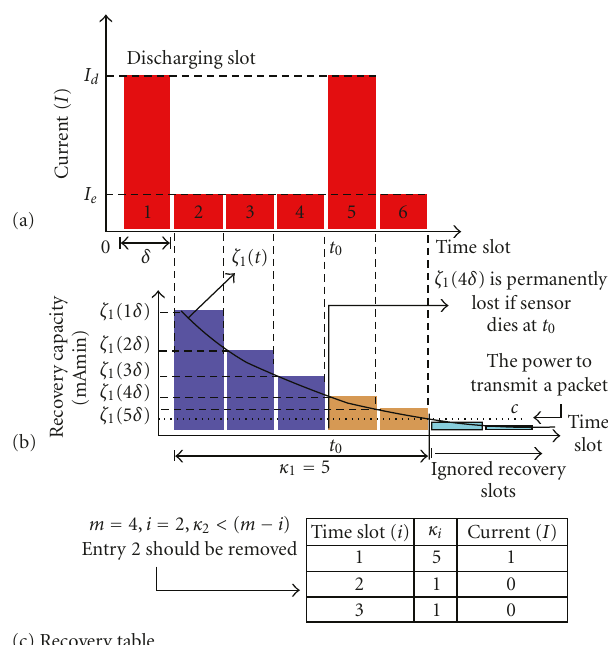
Figure 3: The discharging of a sensor battery. (a) The node is a dominator in slots 1 and 5 and dominatee in slots 2, 3, 4, and 6. (b) The capacity ζ 1 ( t ) is discharged in slot 1 and recovered gradually in the following slots. ζ 1 ( t ) after slot 6 is ignored. If this battery dies in slot 5, ζ 1 (4 δ ) is permanently lost. (c) The recovery table records the recovery status κ i at m = 4. The 0 and 1 in the current column stand for I d and I e ,